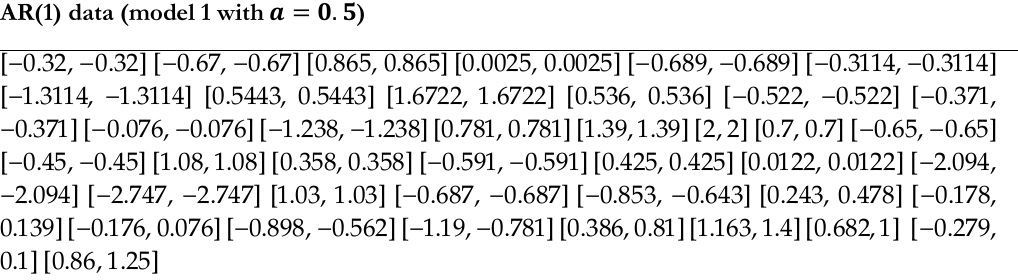
Table 2. Neutrosophic AR (1) data from normal